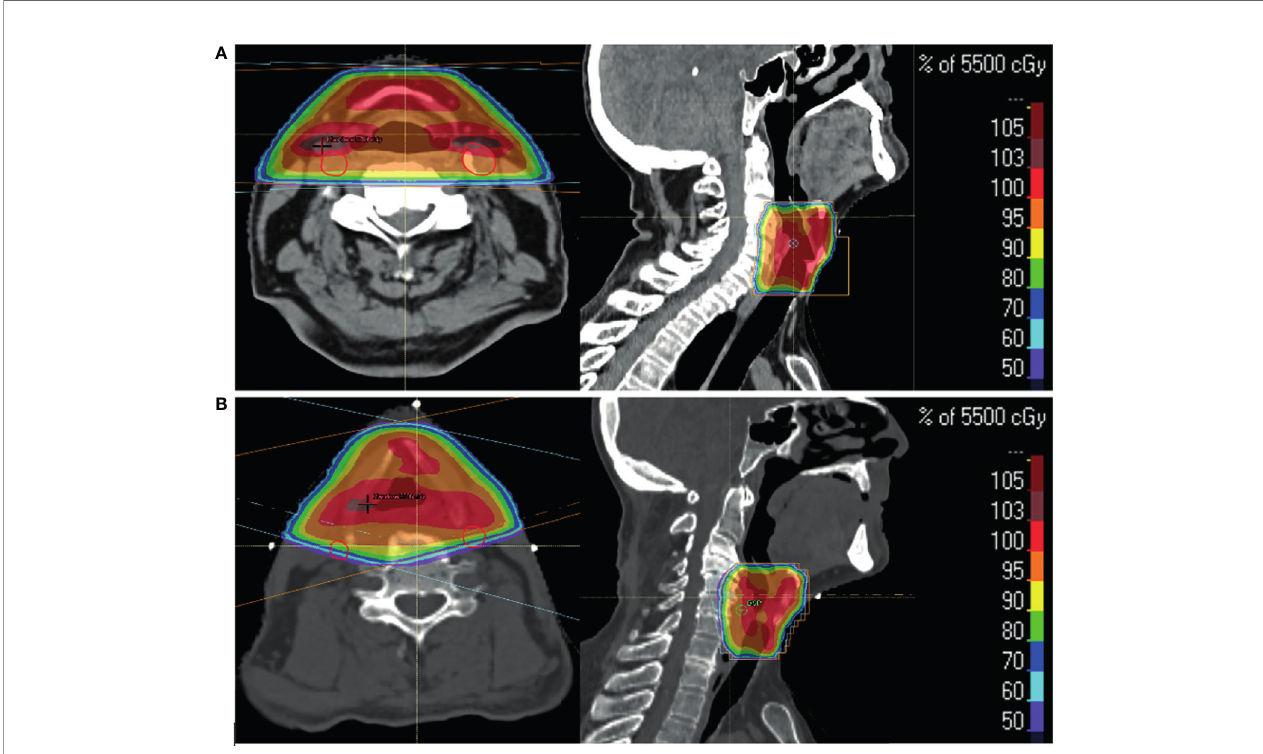
FIGURE 1 | Two patients with T1a glottic SCC treated with radical radiotherapy to a dose of 55 Gy in 20 fractions over 4 weeks. Axial and sagittal images show percentage dose coverage from a bilateral parallel-opposed (A) and anterior-oblique (B) beam arrangement. Carotid arteries (red) highlight their proximity to the primary targets and doses